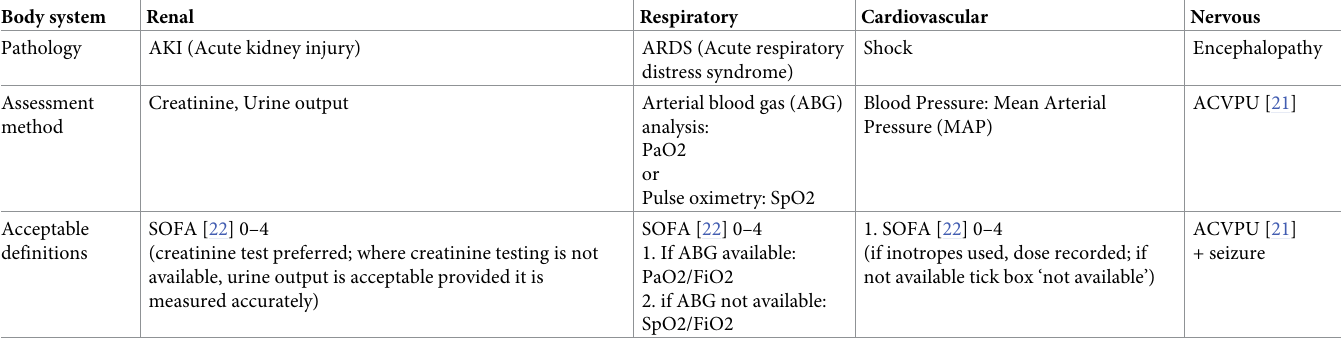
Table 2. Definition of Unfavourable Outcome